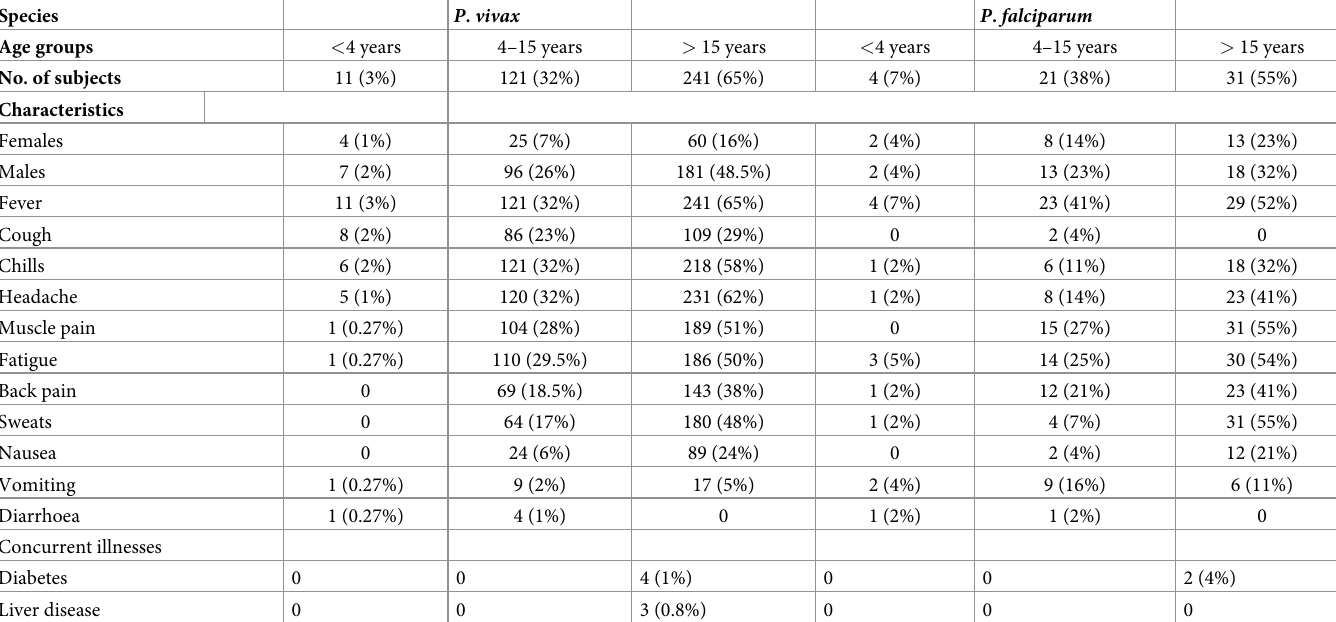
Table 3. Patients’ history according to the malaria parasite species [18,